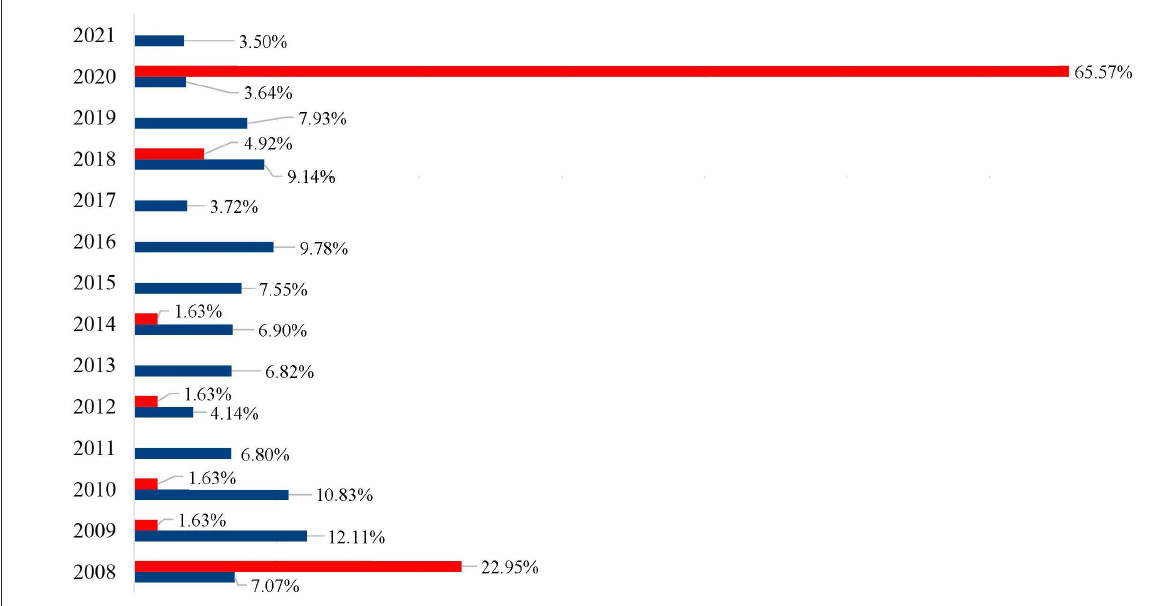
2009 (Figure 2), when 2,085 specimens were received by the laboratory (12.12% of the total number of A. fulica specimens registered at the